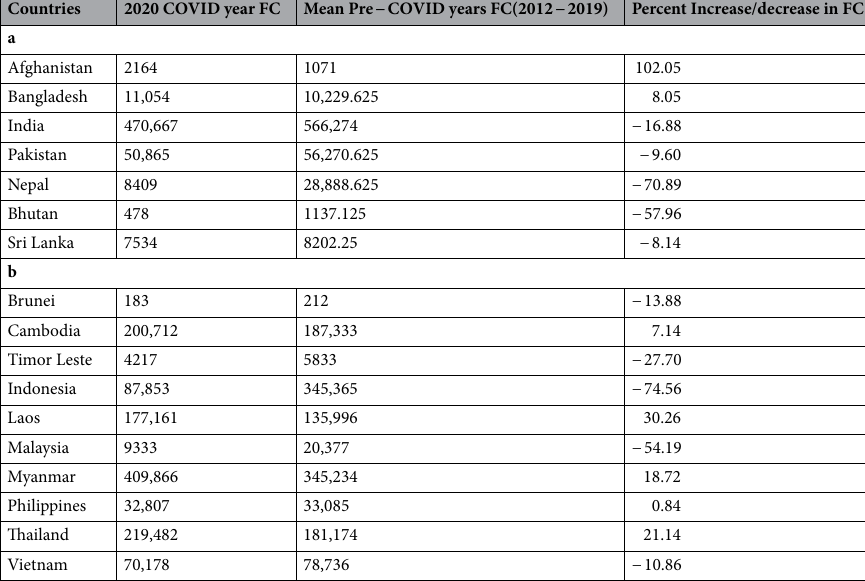
Table 3. a, b. Percent increase/decrease in VIIRS (375 m) derived fire counts in South/Southeast Asian countries during 2020 COVID year versus pre-COVID years (2012–2019).